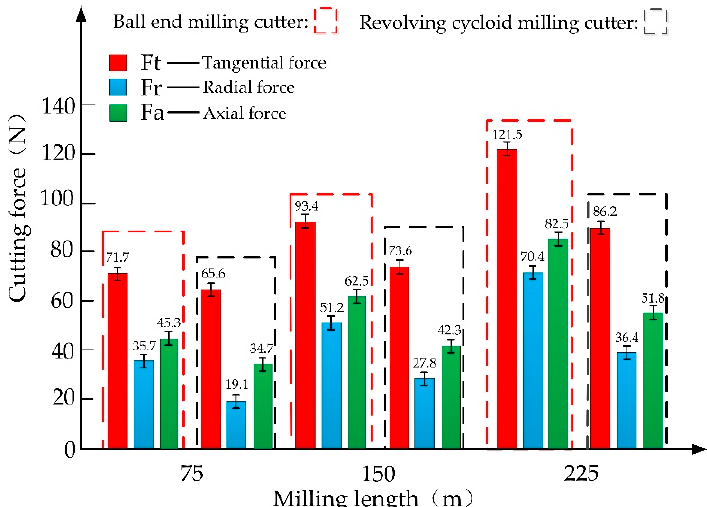
Figure 12. Comparison of the maximum cutting force between two kinds of cutters.